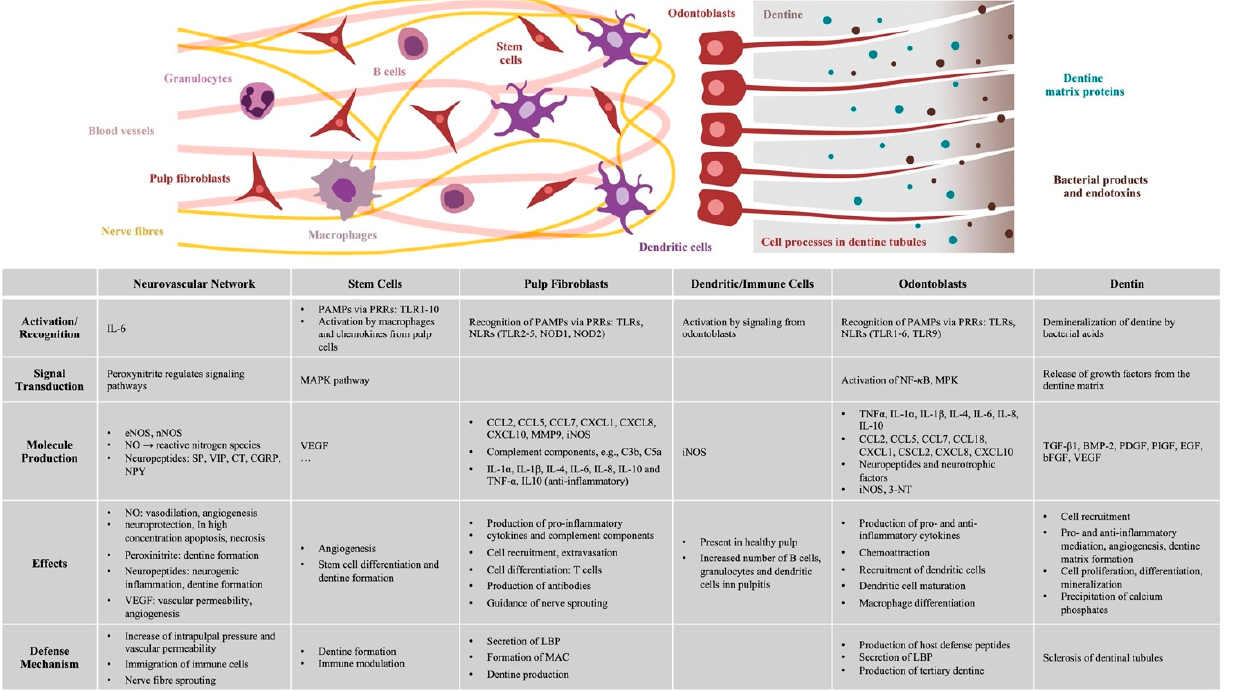
Figure 4. Outline of all structural and cellular components involved in the immune defense of the dental pulp.